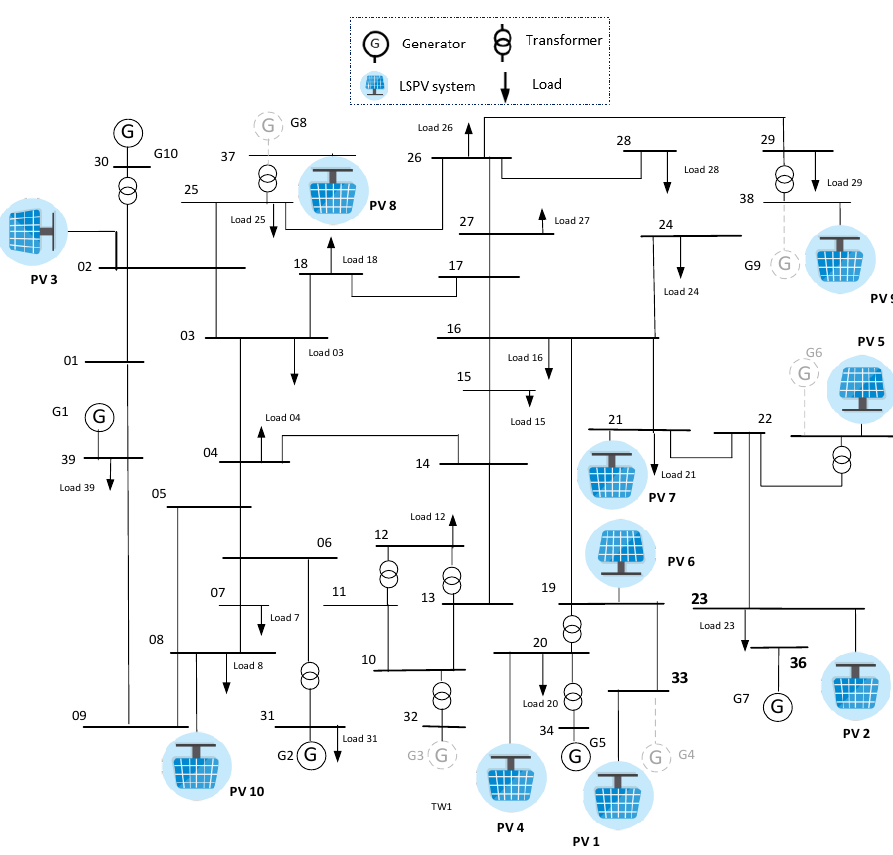
Figure 2. Modified solar PV integrated New England system.